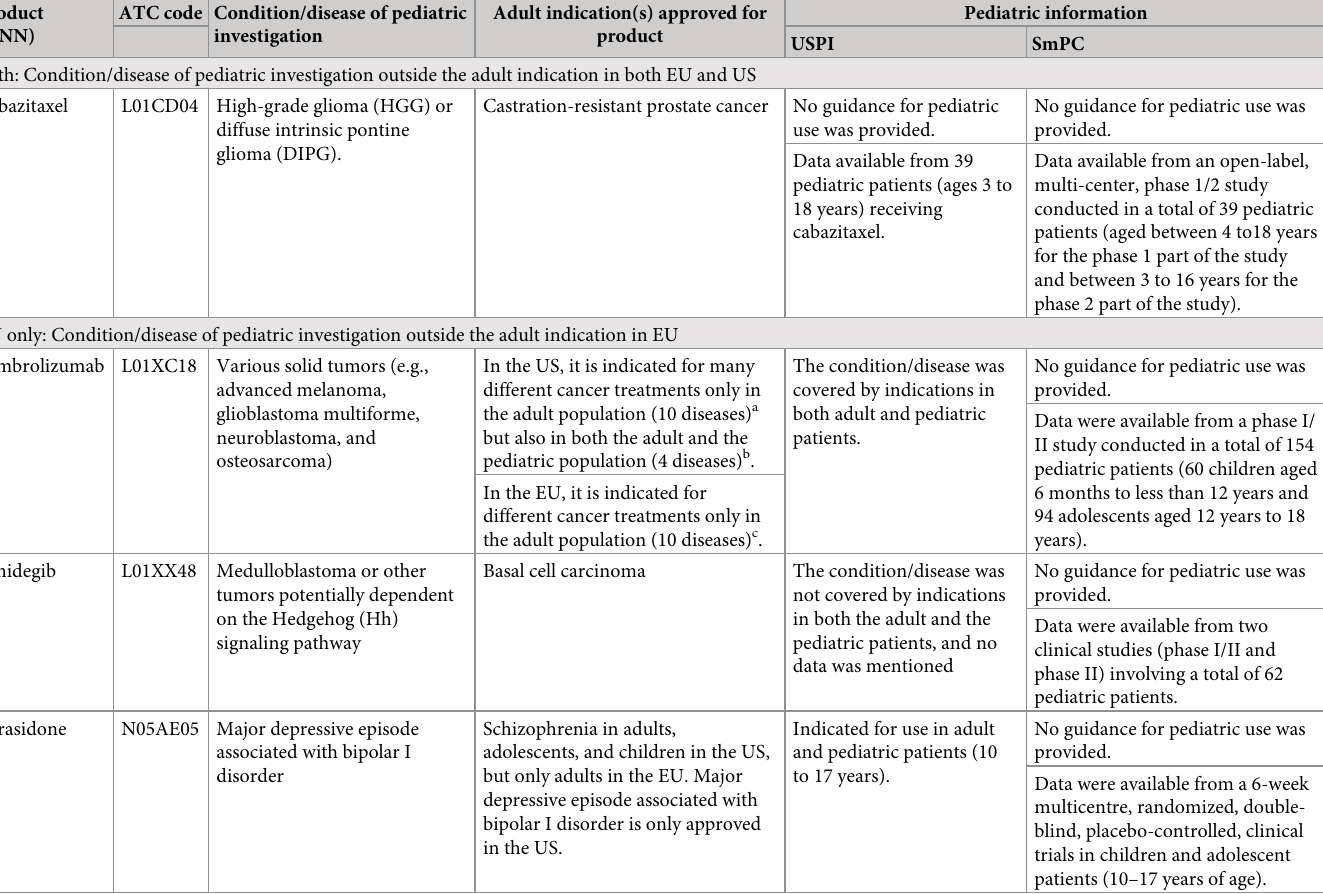
Table 8. Summary of pediatric data available for a condition and disease outside the adult indications in the SmPC (n = 4) and the USPI (n = 1). Pediatric-only indi- cations not